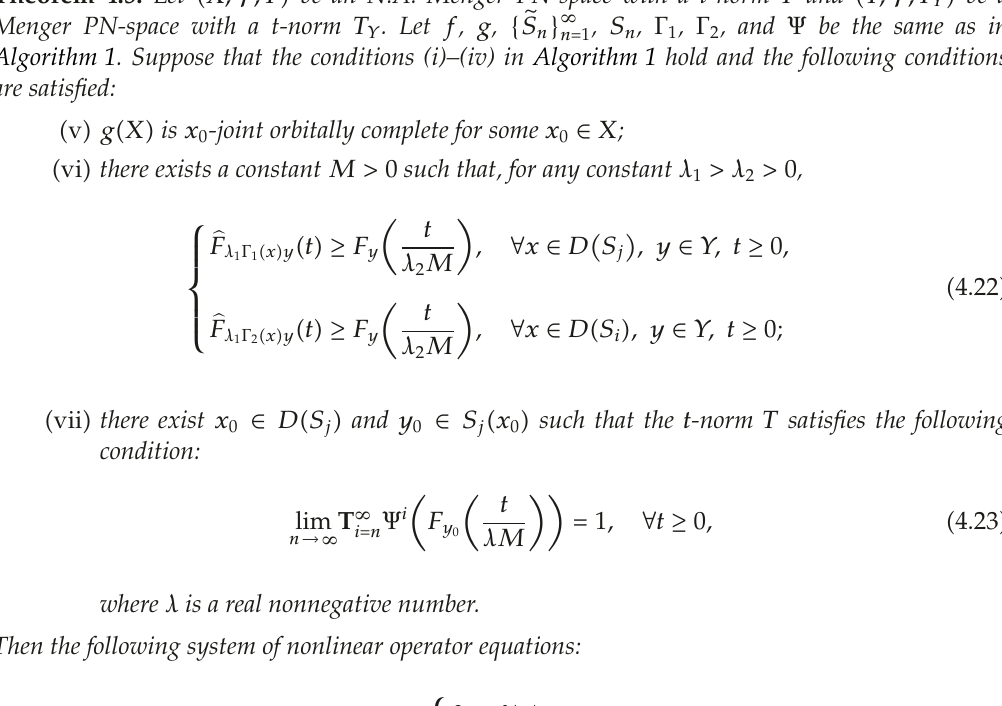
Algorithm 2. Let (cid:5) X, PN-space with a t -norm T Y , and A, V : X → X be two operators. Let {